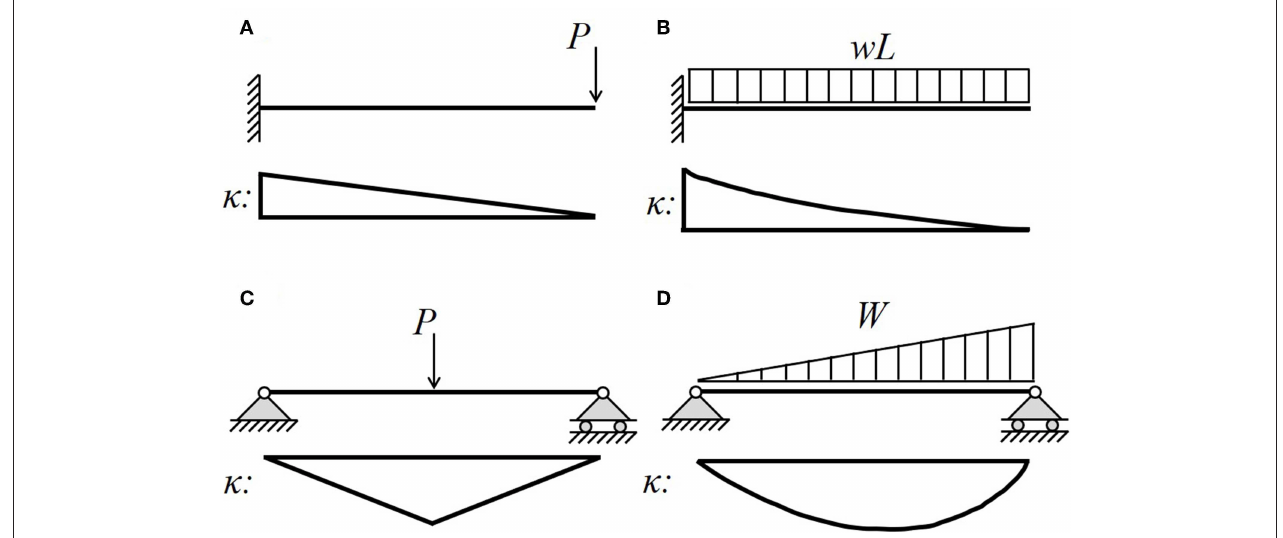
FIGURE 2 | Static numerical simulation loading conditions and curvature profiles: (A) cantilever with point load-linear, (B) simply supported with central point load- broken linear, (C) cantilever with uniform distributed load-quadratic, and (D) simply supported with uniformly increasing distributed load-cubic.